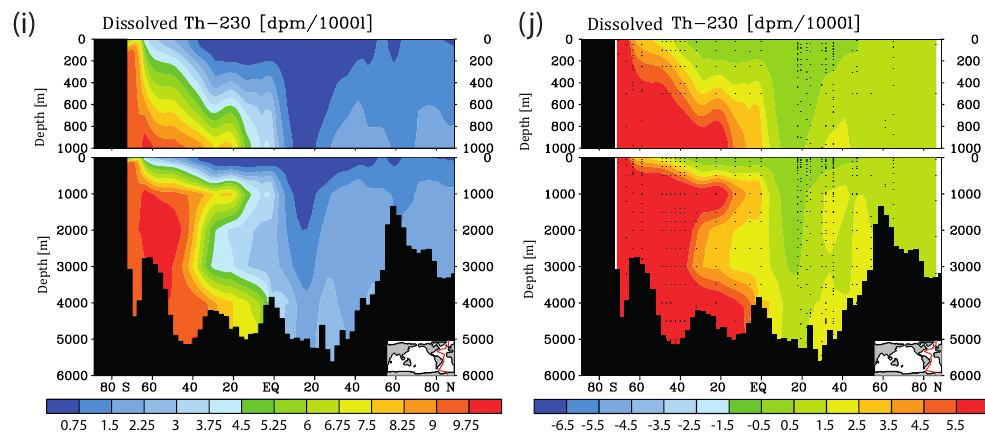
Figure 7. Meridional dissolved 230 Th Atlantic Ocean cross sections in dpm/1000L (dpm indicates disintegration per minute) for sensitivity experiments. (a) K d increased everywhere (by log (K d ) =+ 0.2). (b) Same as panel (a) but the difference between model and observations. (c) K d increased only in the model grid cells directly over the ocean floor (see text). (d) Same as panel (c) but the difference between model and observations. (e) Clay flux increased to 100% of control run value. (f) Same as panel (e) but the difference between model and observations. (g) No scavenging to POC. (h) Same as panel (g) but the difference between model and observations. (i) No scavenging to CaCO 3 . (j) Same as panel (i) but the difference between model and observations. Please note changes in colour codes relative to panels (a) – (h) . (Observed data are from the GEOTRACES intermediate data product; for references, please see the